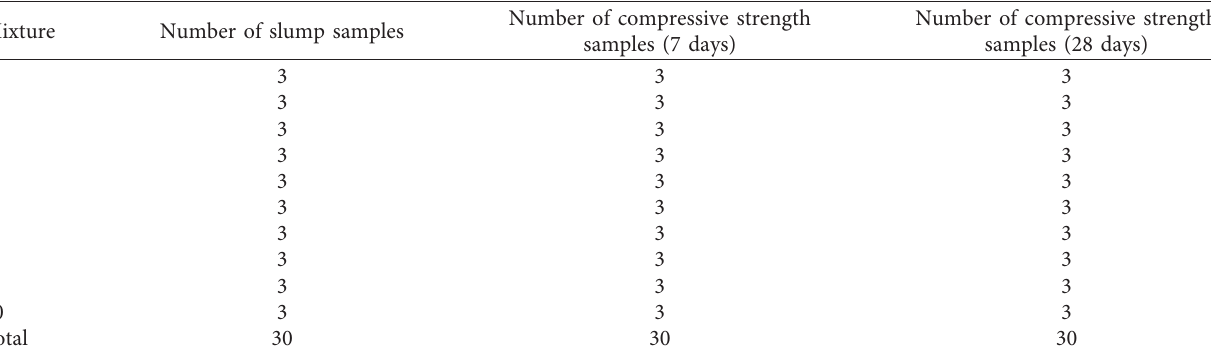
Table 3: Number of tested samples for slump and compressive